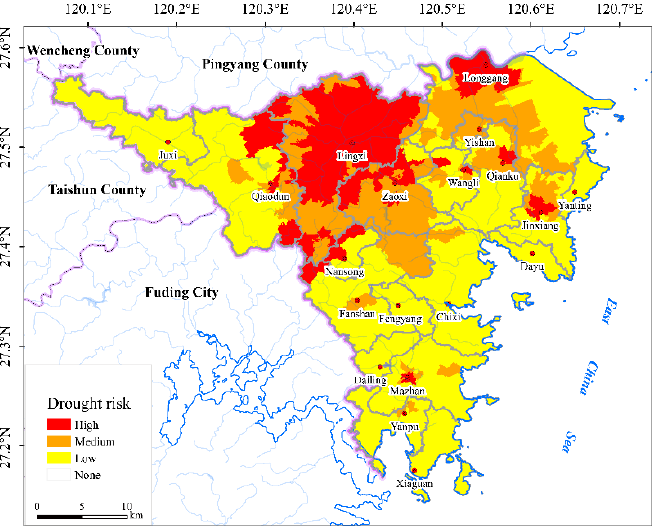
Figure 7. Spatial pattern of comprehensive drought risk in Cangnan County.